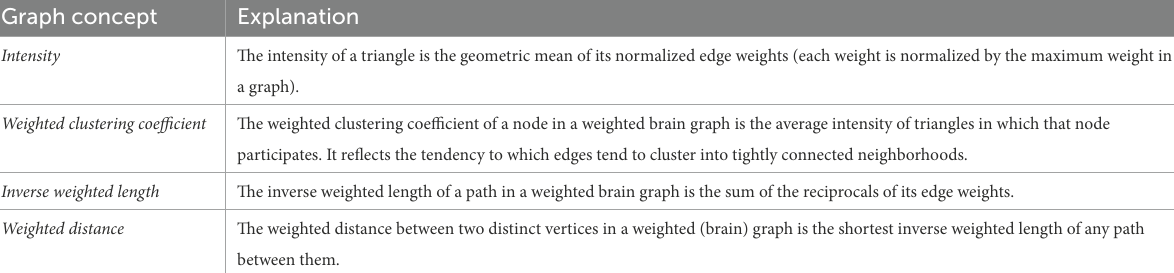
TABLE 2 Traditional measures on a weighted brain